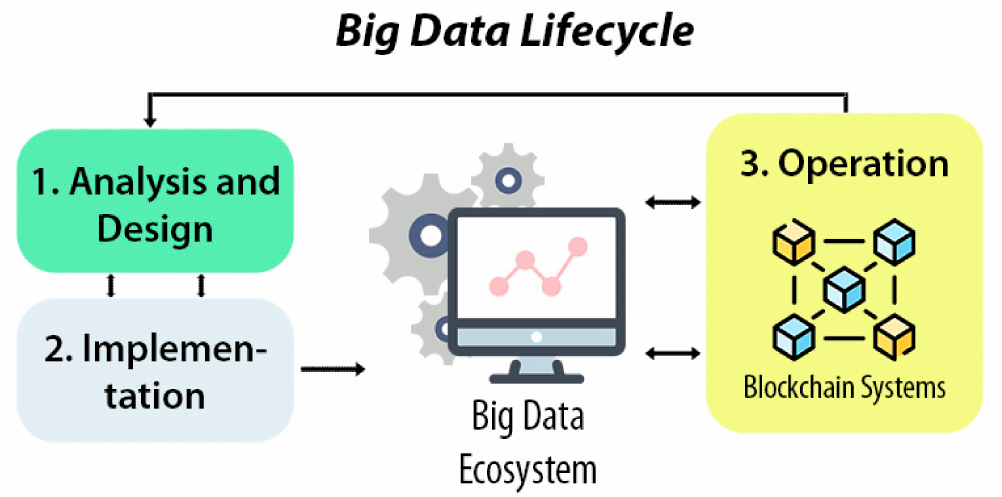
Figure 2. A lifecycle for a big data